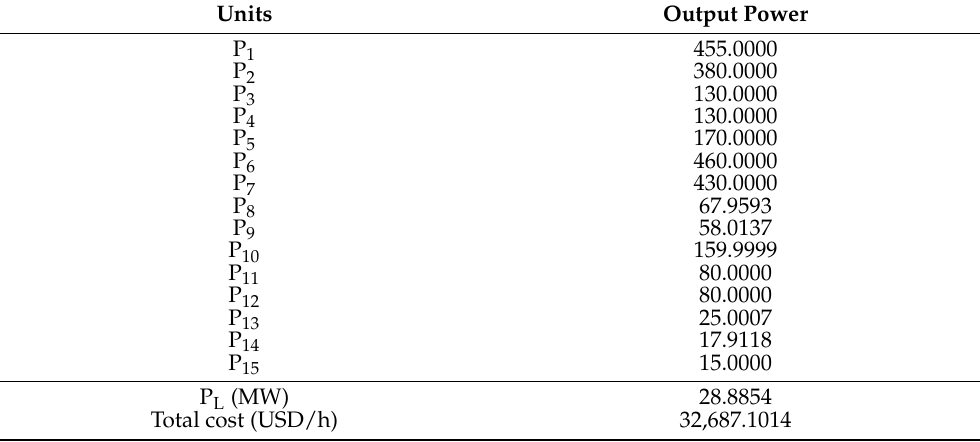
Table 8. The best decision variables for Case B-type 2 obtained by G-SCNHGWO algorithm.